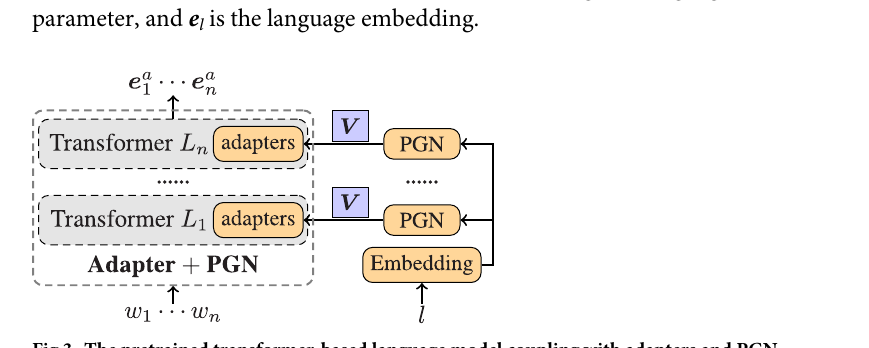
Fig 3. The pretrained transformer-based language model coupling with adapters and